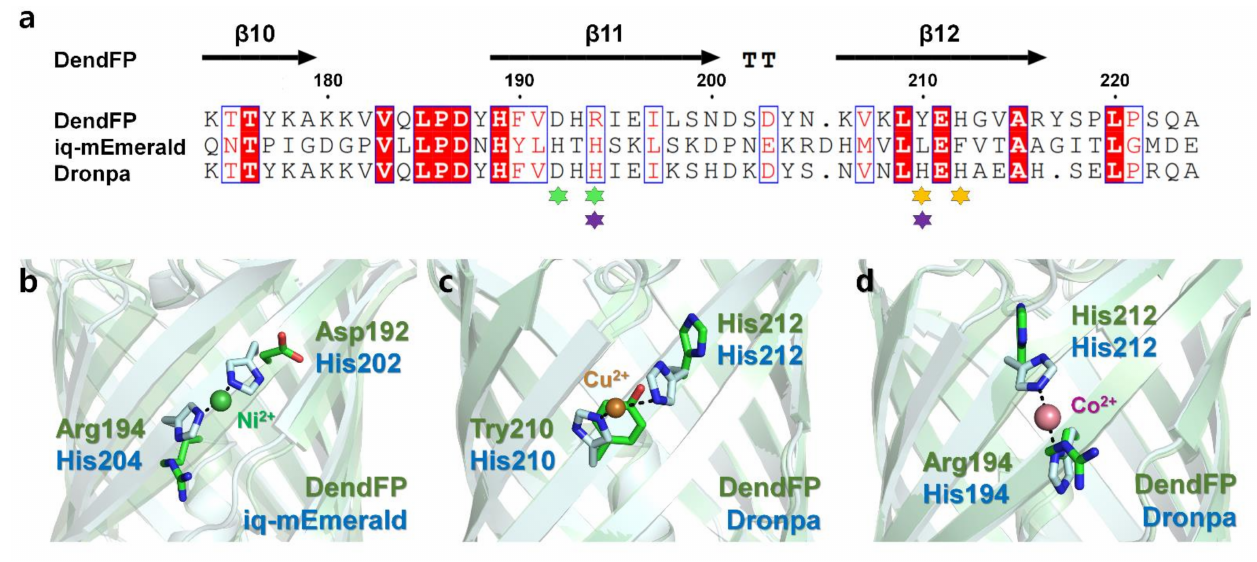
Figure 8. Comparison of the metal-binding sites of DendFP with those of iq-mEmerald and Dronpa. ( a ) Sequence alignments of DendFP with iq-mEmerald and Dronpa. The metal-binding sites of iq-mEmerald (green, Ni 2+ ) and Dronpa (orange for Cu 2+ ; purple for Co 2+ /Ni 2+ ) are indicated by an asterisk. Superimposition of DendFP with ( b ) Ni 2+ -bound iq-mEmerald (PDB code: 4KW4), ( c ) Cu 2+ -bound Dronpa (5HZT), and ( d ) Co 2+ -bound Dronpa